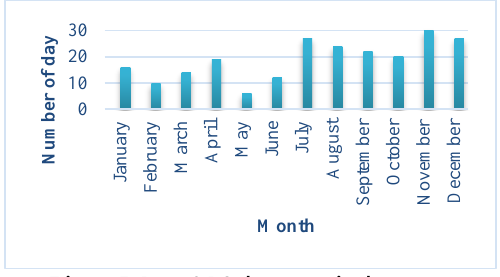
Figure 5. Raw GPS data acquired over a year.